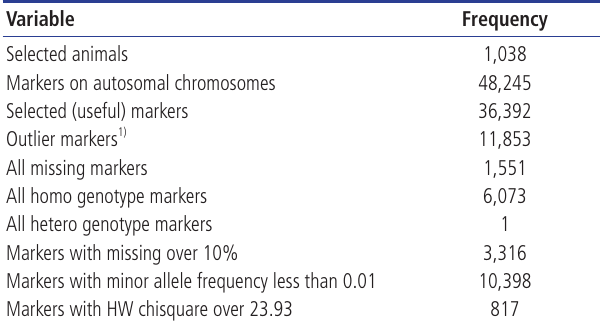
Table 1. Frequency of variables after the quality control of raw single nucleotide polymorphisms dataset Variable Frequency Selected animals 1,038 Markers on autosomal chromosomes 48,245 Selected (useful) markers 36,392 Outlier markers 1) 11,853 All missing markers 1,551 All homo genotype markers 6,073 All hetero genotype markers 1 Markers with missing over 10% 3,316 Markers with minor allele frequency less than 0.01 10,398 Markers with HW chisquare over 23.93